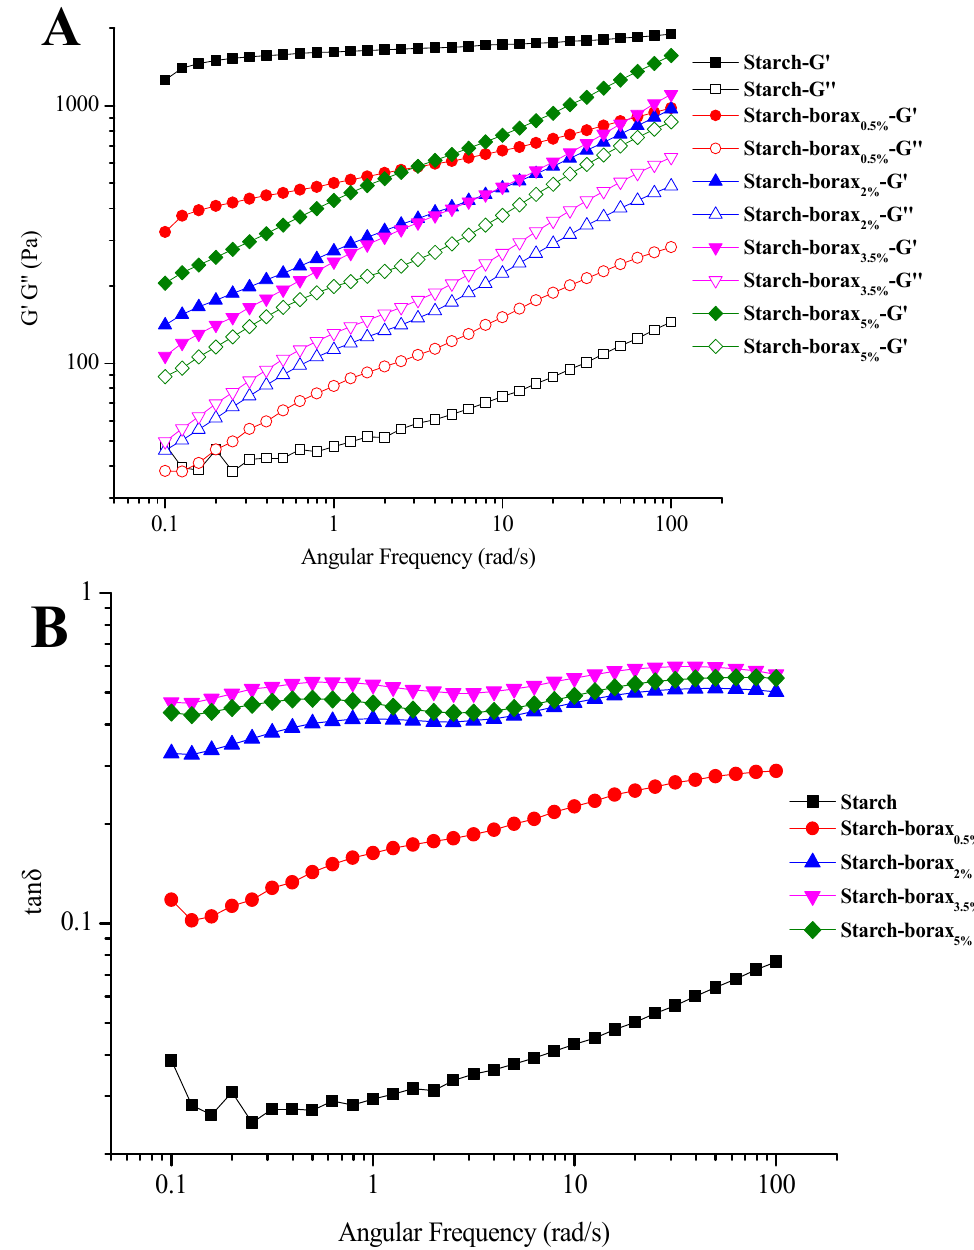
Figure 1. Frequency dependence of the G ′ , G ″ ( A ) and tan δ ( B ) values of starch pastes with different content levels of borax at 50 °C.